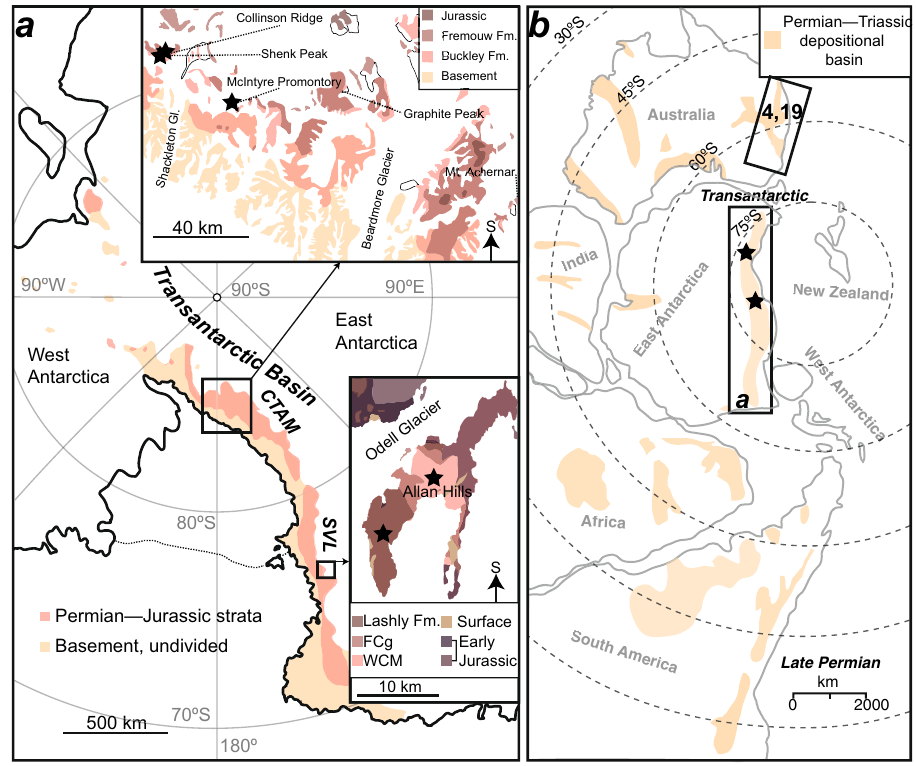
Figure 1. Map and paleogeography of the study area. ( a ) Map of the study locations, CTAM and SVL, on Antarctica. Exposures of major geologic units are shown, ice/snow where not shaded. ( b ) Paleogeographic reconstruction of the late Permian for Gondwana. Permian–Triassic depositional basins are shaded, study locations indicated by stars. The boxed region of eastern Australia highlights the correlative stratigraphy discussed in the text 4,19 . Figure created using Adobe Illustrator, v. 25.0.1,